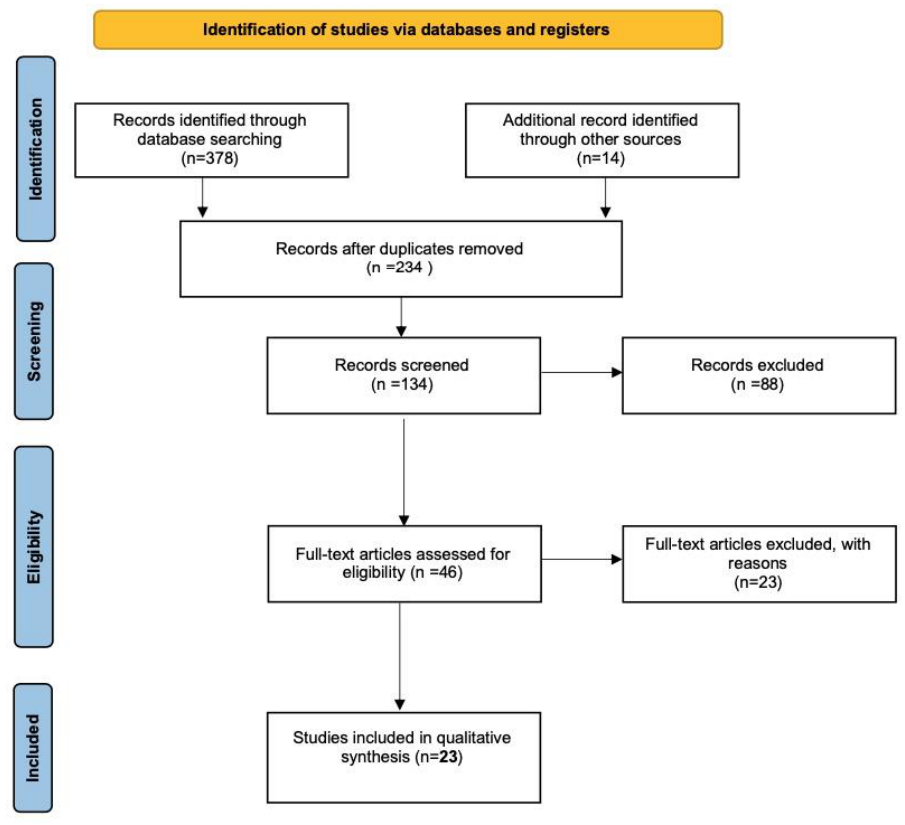
Figure 1. Flow diagram of study identification and selection.